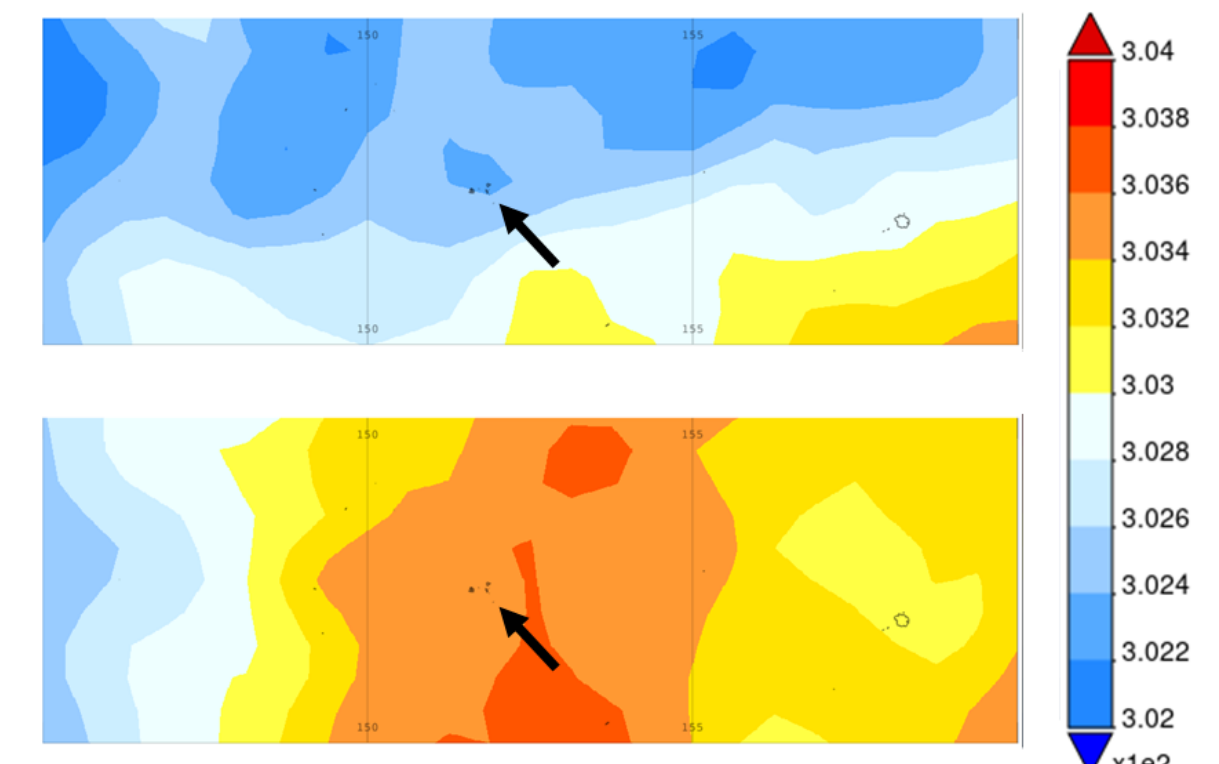
Figure 12 . Time-averaged maps of MERRA-2 SSkT created with NASA Giovanni. ( top ) Minimum SSkT occurring on 27 September 2013, 23:00 Z. ( bottom ) Maximum SSkT occurring on 3 October 2013, 23:00 Z. The color scale is from 302 to 304 Kelvin (28.85 – 30.85 °C).